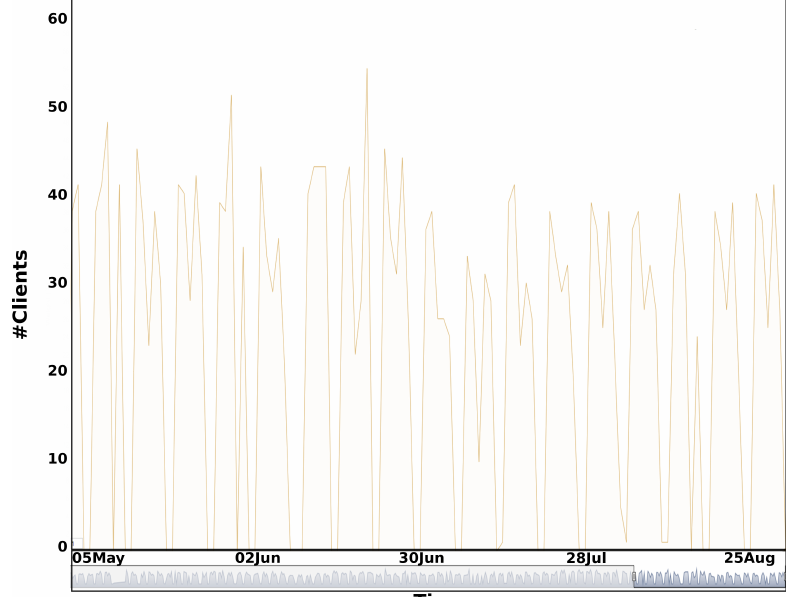
Figure 23. Number of clients served for the south waste collection tour between January-September 2019 (Average: 34 clients, standard deviation: 7